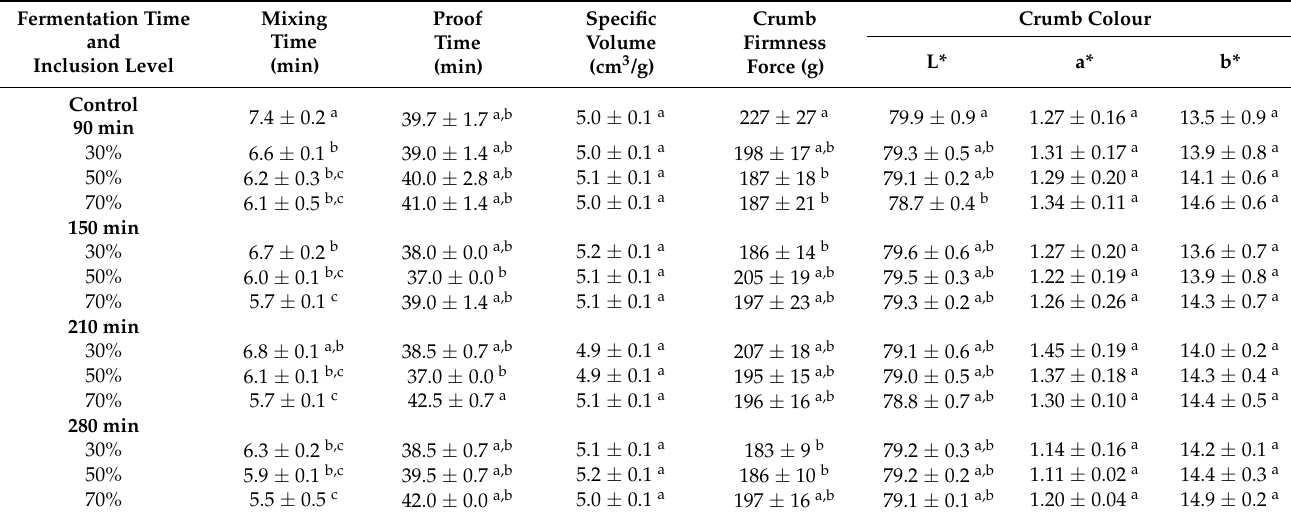
1 Different letters within the same column indicate significant differences for the results for each parameter at p < 0.05 (Tukey–Kramer